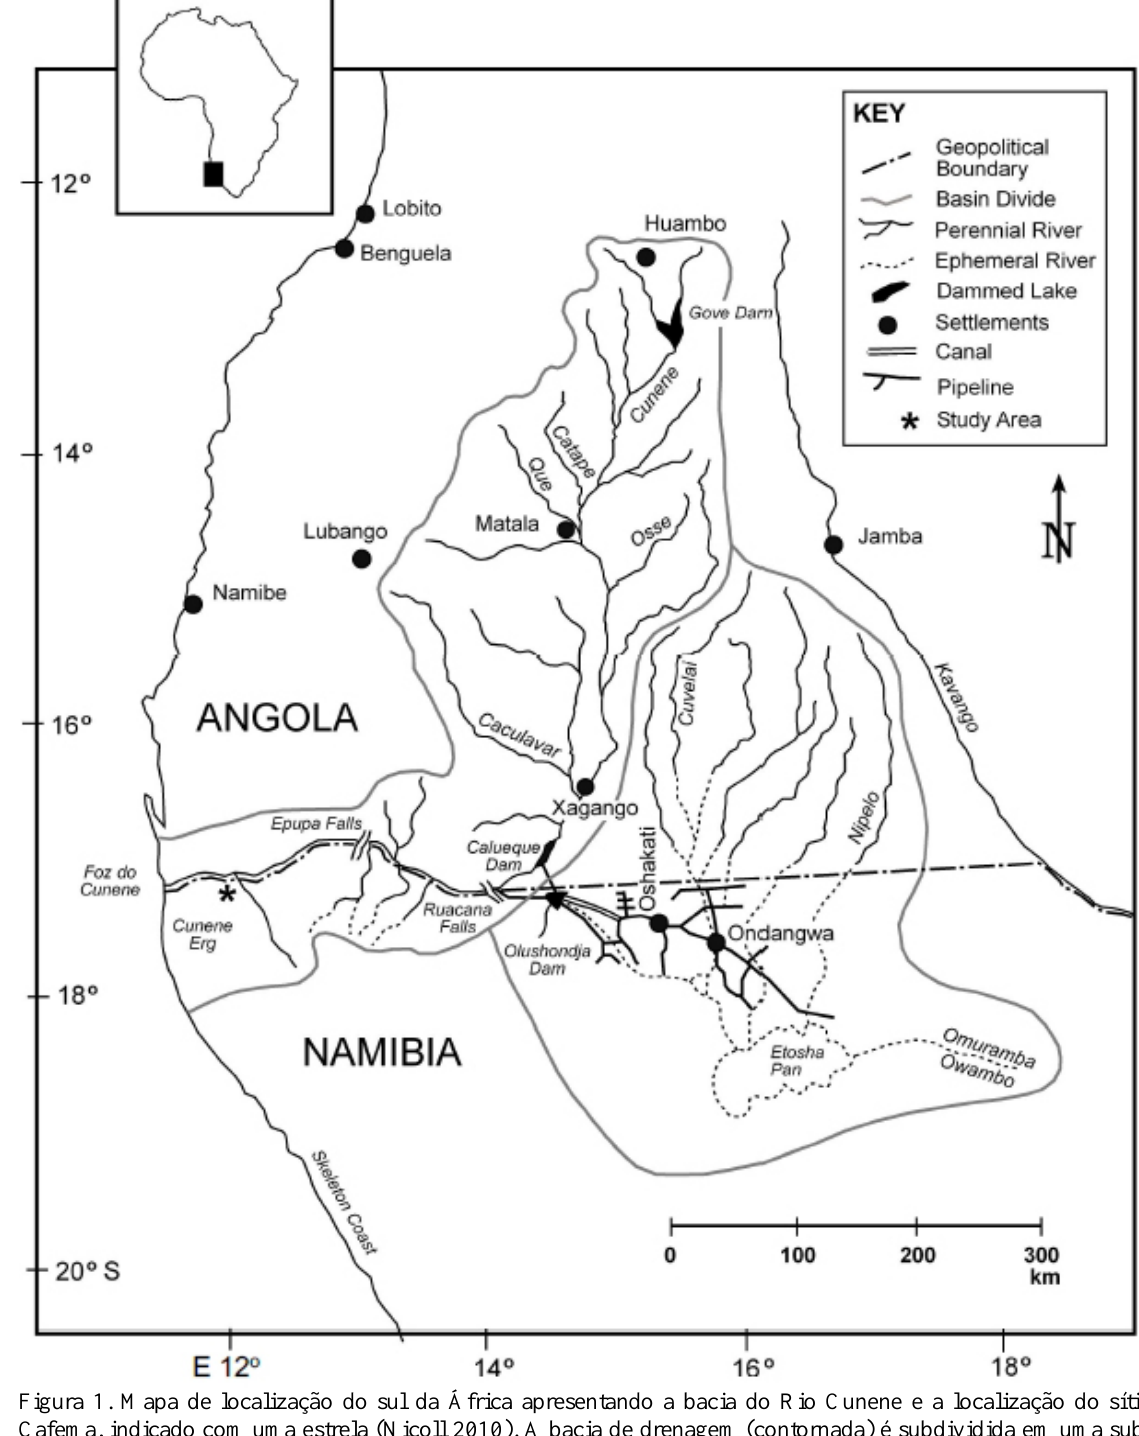
Figura 1. Mapa de localização do sul da África apresentando a bacia do Rio Cunene e a localização do sítio Cafema, indicado com uma estrela (Nicoll 2010). A bacia de drenagem (contornada) é subdividida em uma sub- bacia perene (ao norte) e uma sub-bacia efêmera, presentemente endorréica (ao sul). Assentamentos nas cascatas de maior energia incluem J-I-M (Jamba-Ia-Mina), Matunto, e Calueque. Figure 1. Location map of southern Africa showing the watershed of the Cunene River and the location of Cafema site, denoted with a star just east of the Marienfluss (Nicoll 2010). The drainage basin (outlined) is subdivided into a perennial (northern) and an ephemeral, presently endorheic, sub-basin (southern). Settlements at the major stream knickpoints include J-I-M (Jamba-Ia-Mina), Matunto, and